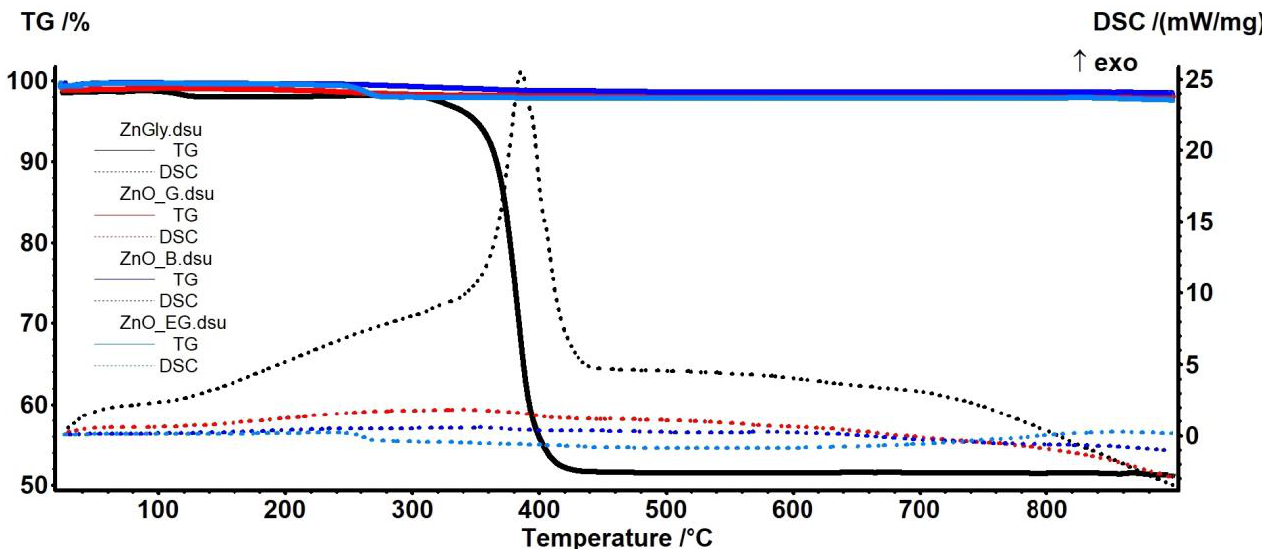
Figure 1. The thermogravimetry (solid) and differential scanning calorimetry (dotted) curves for the ZnO_B, ZnO_EG, ZnO_G and ZnGly samples.